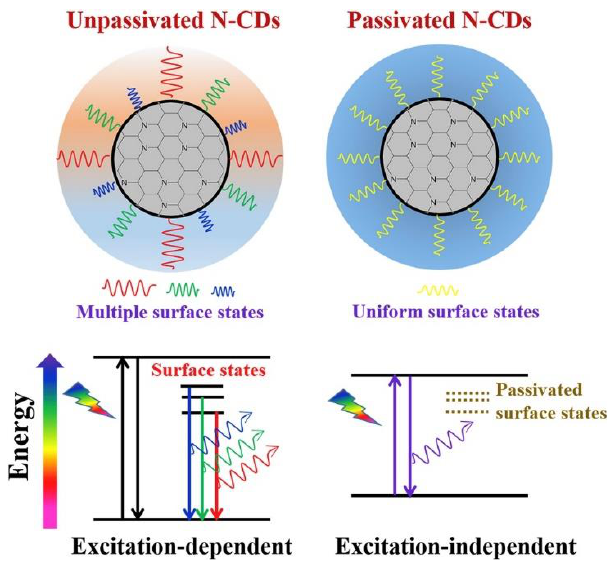
Figure 18. Visualized surface states of N-doped CDs with excitation-dependent and -independent behaviors. (Reprinted from [140]; with the permission of Elsevier).